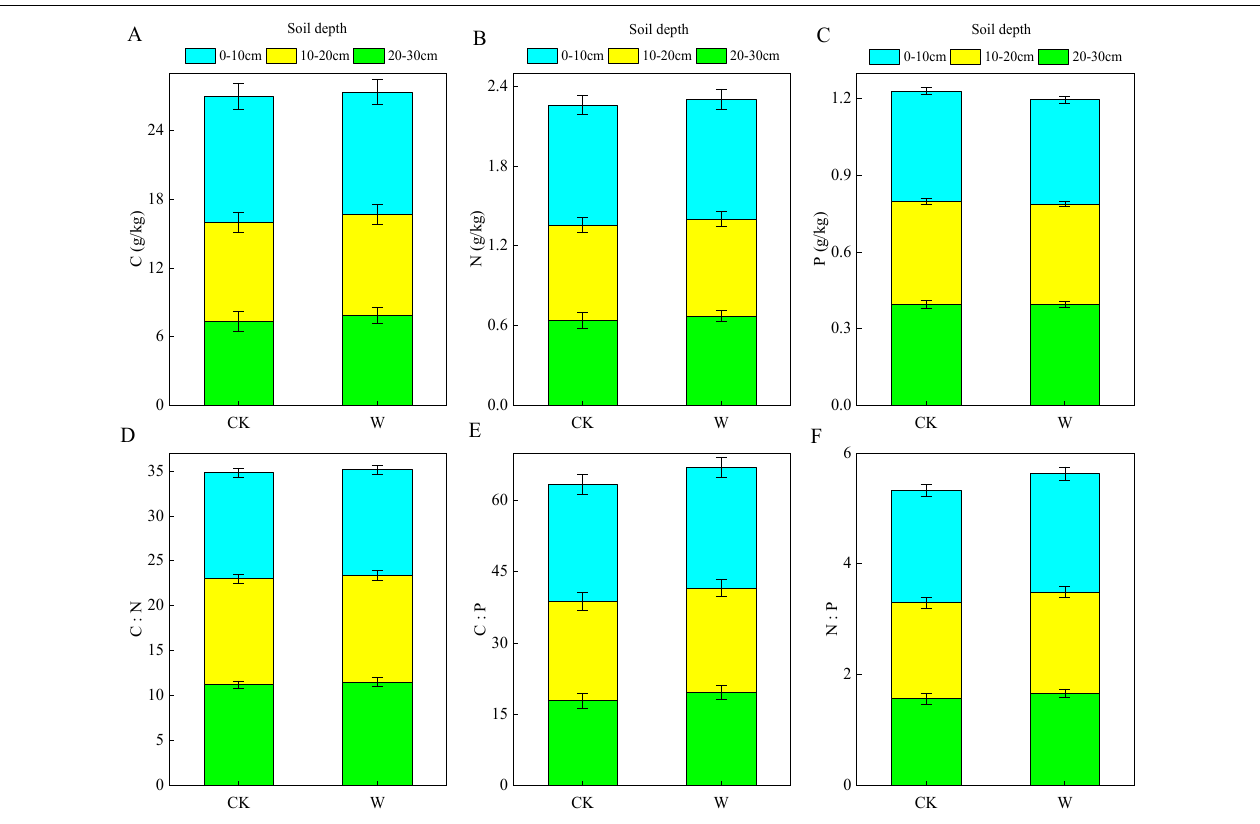
FIGURE 3 | Effects of warming on the soil stoichiometric characteristics with (A) organic carbon (C), (B) total nitrogen (N), and (C) total phosphorus (P) at three soil depths in an alpine meadow. (D) C:N, (E) C:P, and (F) N:P denote the content ratios of C to N, C to P, and N to P, respectively. The three pieces of each column from top to bottom represent the values of the soil stoichiometric characteristics at soil depths of 0–10, 10–20, and 20–30 cm, respectively.